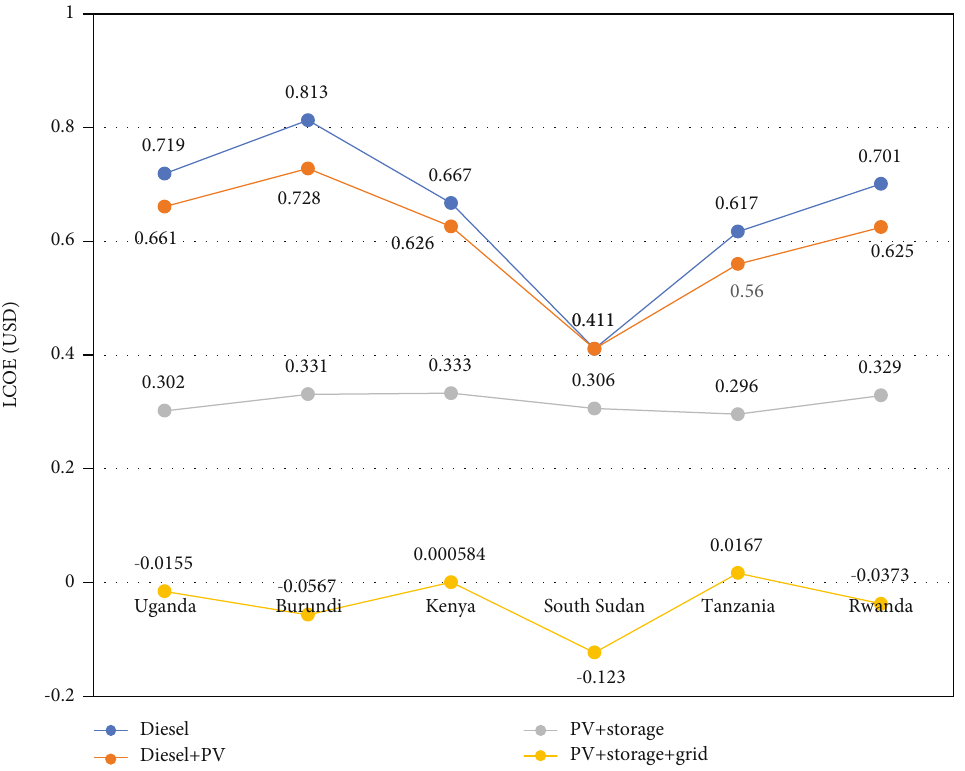
Figure 7: Levelized cost of electricity for all EAC countries with all the analysed energy